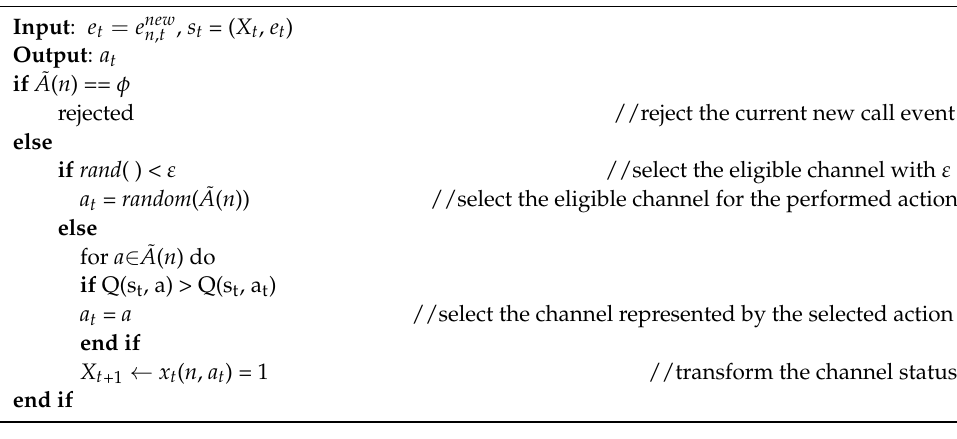
Algorithm 2: Policy for a new call event